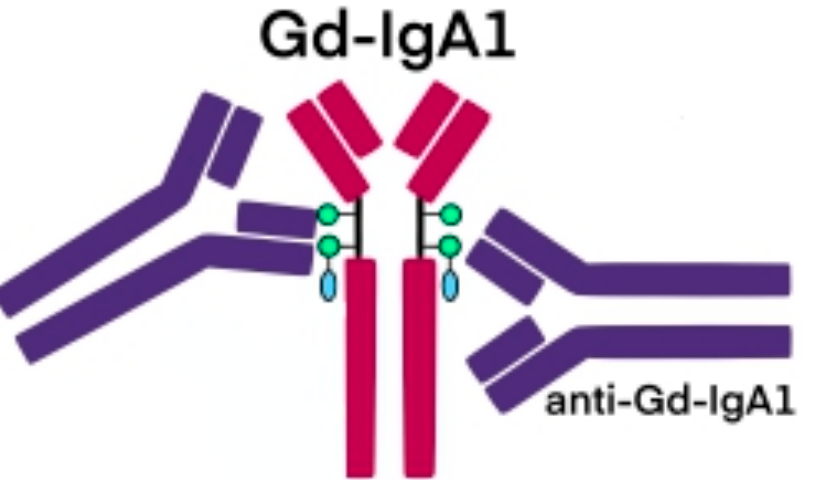
Figure 2. Schematic picture of abnormally glycosylated IgA1 exposing a novel antigenic determi- nant involving N-acetylgalactosamine (GalNAc), which may be recognized by naturally occurring specific antibodies.